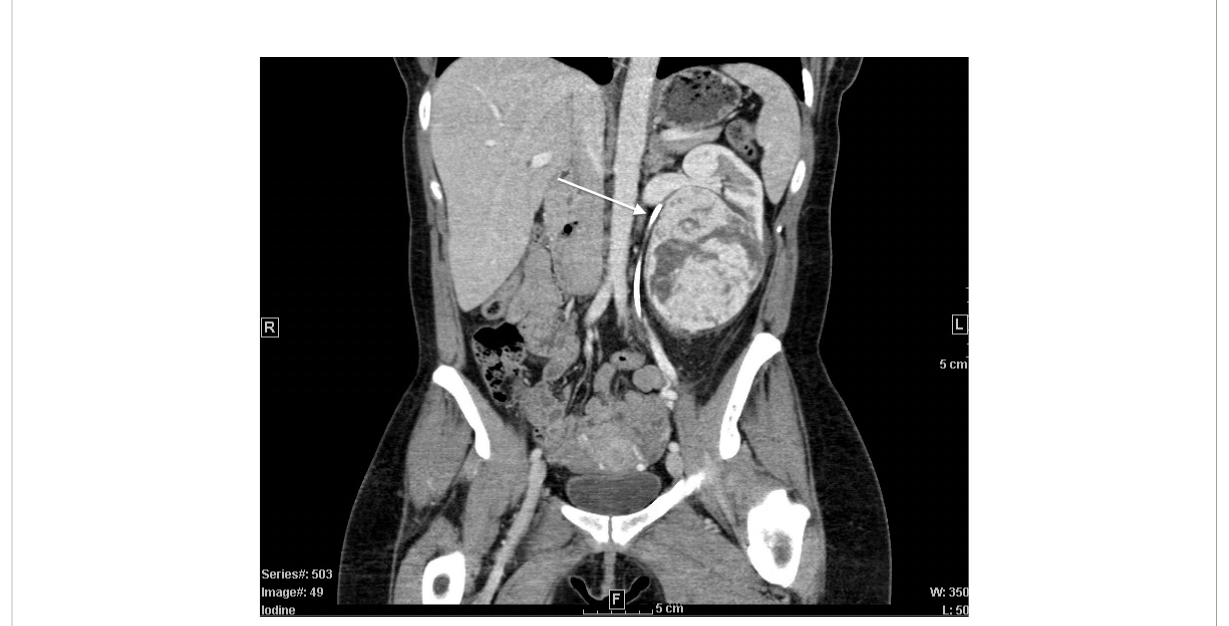
FIGURE 1 CT-Abdomen with IV contrast. Coronal view demonstrating large, 7.5x8.3x10.0cm heterogeneous solid mass in solitary left kidney. Stent in place (white arrow) , indicating compressed and arched ureter superior to the